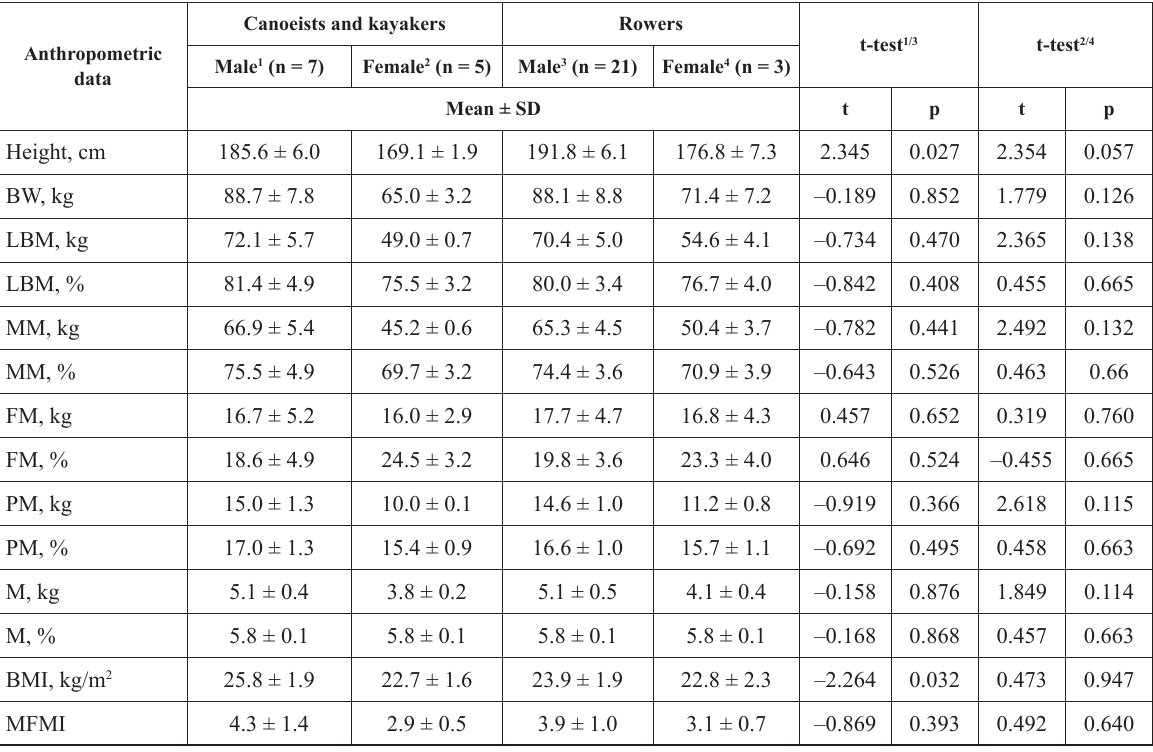
Table 2. Anthropometric data of Lithuanian Olympic team canoeists, kayakers and rowers